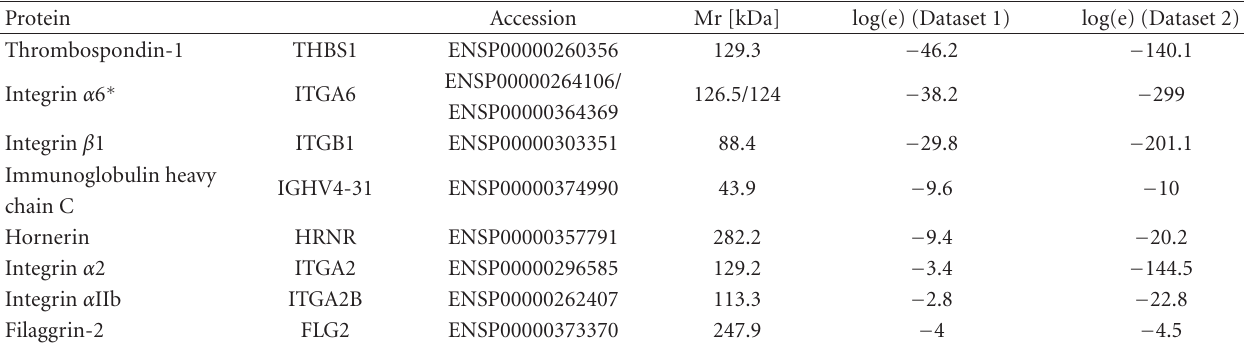
Table 3: Proteins identified in the integrin β 1 complex precipitated from human platelets. Integrin β 1 was precipitated by JB1B from formaldehyde cross-linked platelets. The integrin β 1 complexes were identified by SDS PAGE analysis and investigated by LC-MS/MS and the GPM. Only proteins with a log(e) < − 2 and which were identified in both datasets are listed. ∗ Two di ff erent isoforms were detected in the experiments.